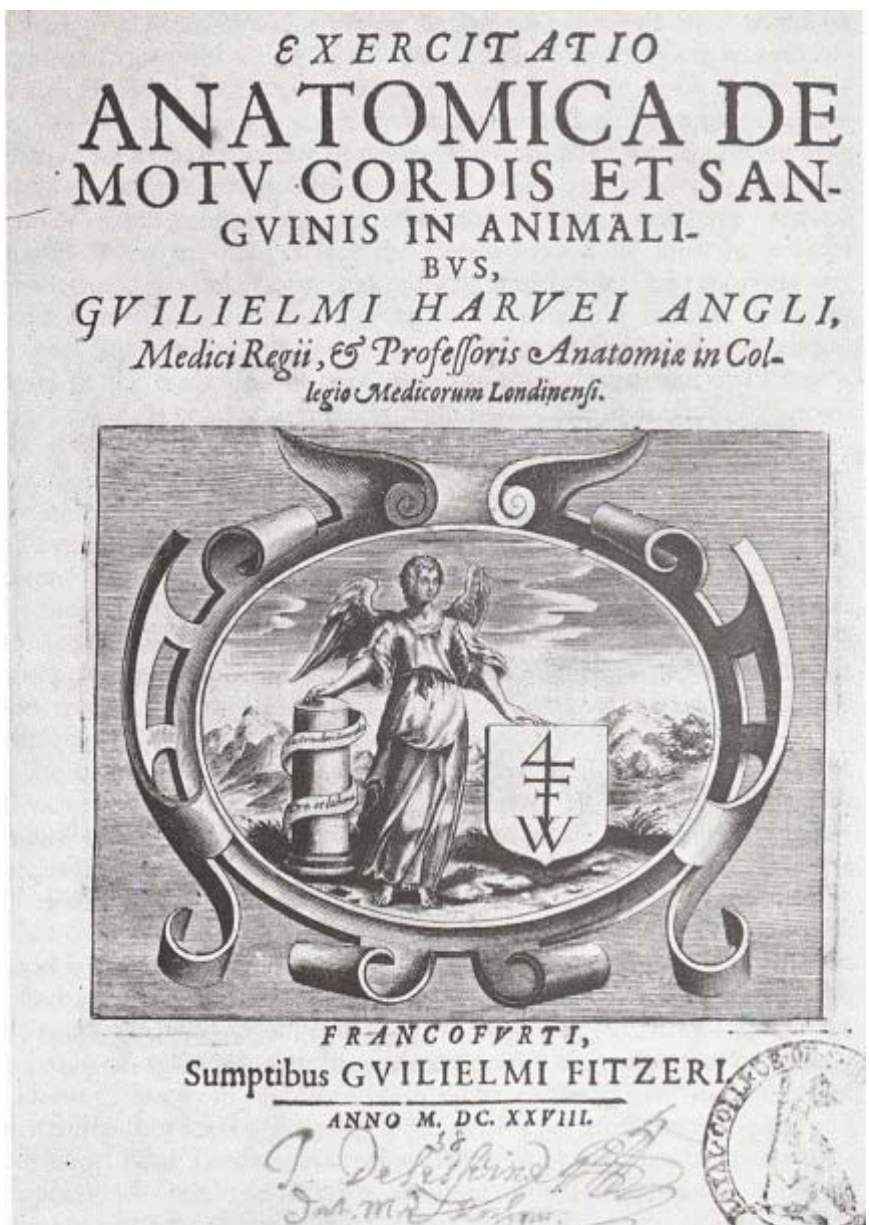
Figure 1. Title page of Exercitatio anatomica de motu cordis et sanguinis in animalibus , 1628